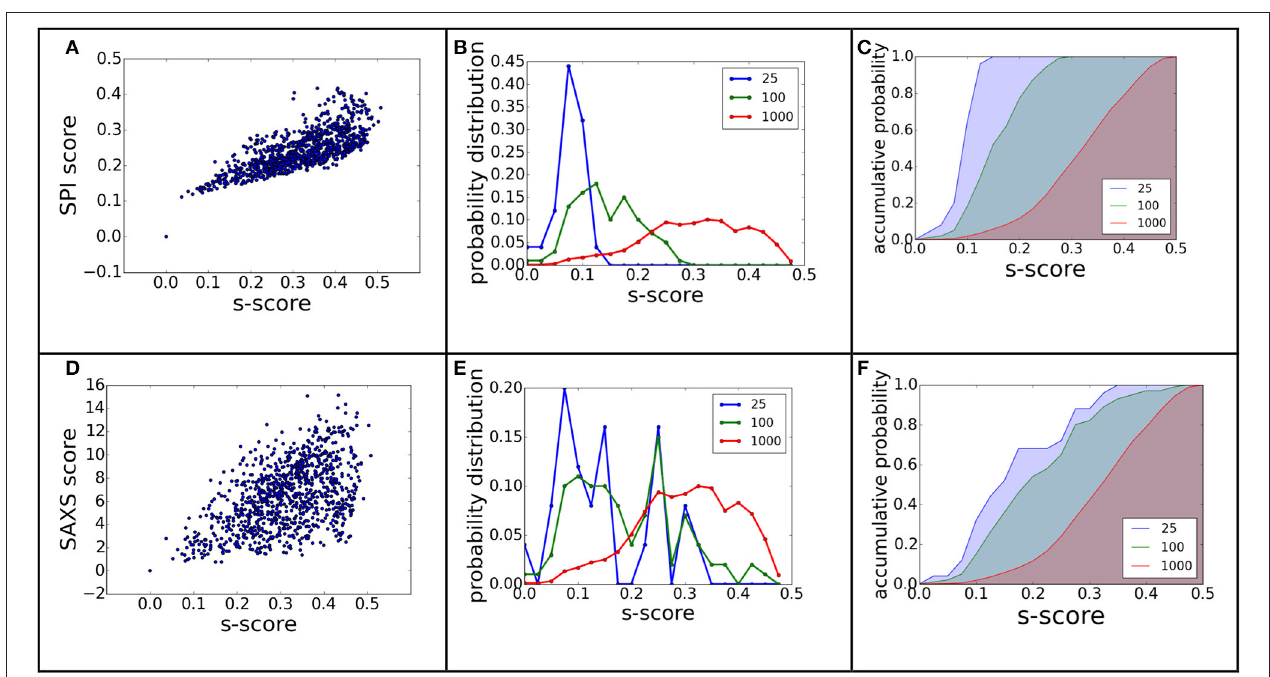
FIGURE 7 | The ranking power revisited using electron density map differences. The figure (A–F) caption is the same as Figure 3 , except that the model difference is measured using s-score , instead of RMSD.